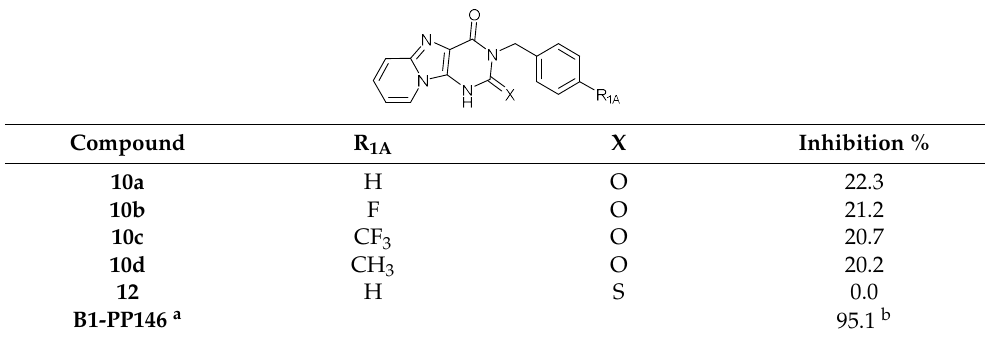
Table 2. Mtb ThyX inhibition at 200 µM by the NADPH oxidase assay of the benzyl derivatives 10 and 12 .